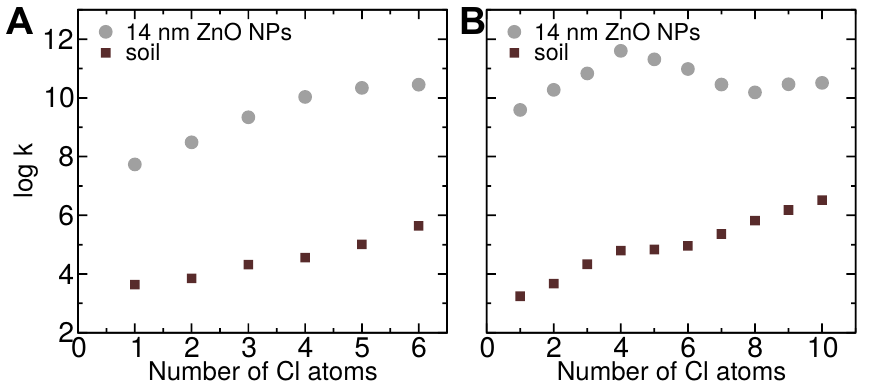
Figure 11. Comparison of adsorption coefficients on 14 nm ZnO NPs and a sample of soil. ( A ) Ad- sorption coefficients for chlorobenzene adsorption. ( B ) Adsorption coefficients for PCB